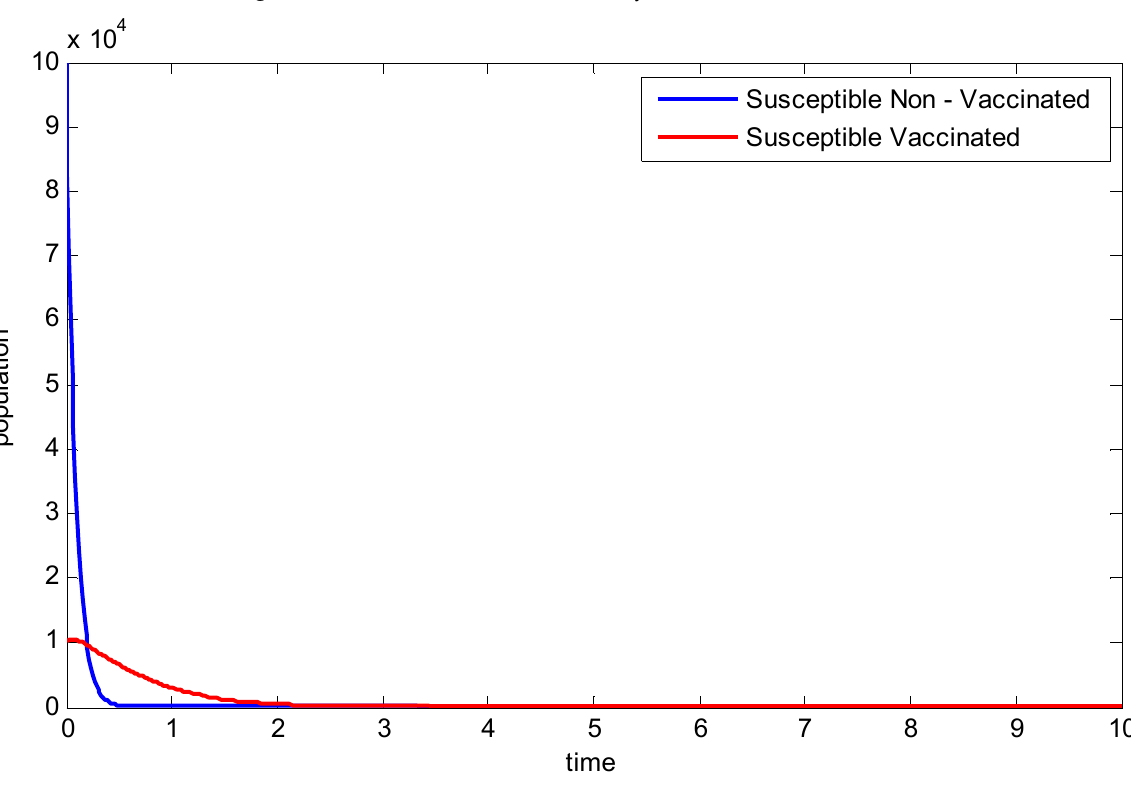
Figure 2. Numerical simulations of the system of FODE (1)–(6).